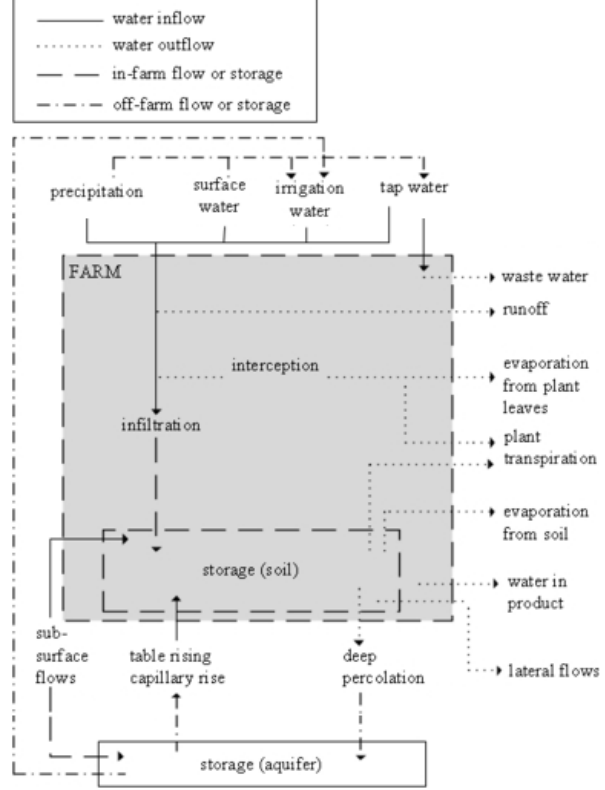
Fig. 1. System boundaries and water inflows and outflows for the calculation of the water demand at the farm level. Perspiration and respiration of animals will not be considered. Evaporation within livestock may appear due to leakage of the cleaning and drinking systems.